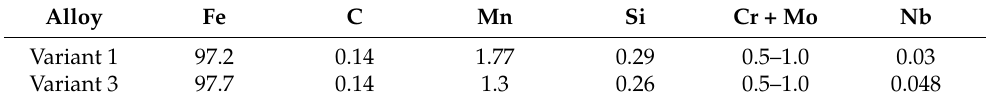
Table 1. Chemical composition (wt%) of the DP 800 steel used for the Variant 1 and Variant 3 study. Alloy Fe C Mn Si Cr + Mo Nb Variant 1 97.2 Variant 3